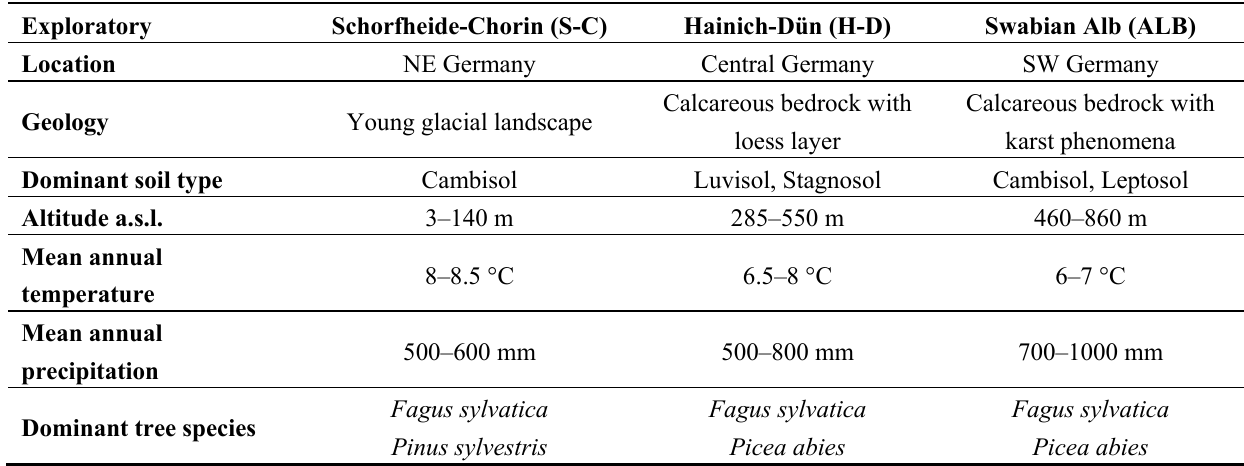
Table 1. Main characteristics of the three Biodiversity Exploratories